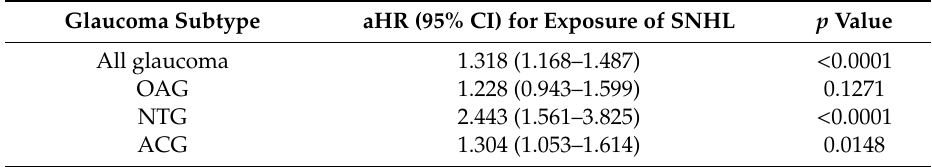
Table 4. Multiple Cox proportional hazard regression for estimation of adjusted hazard ratios on di ff erent types of glaucoma.